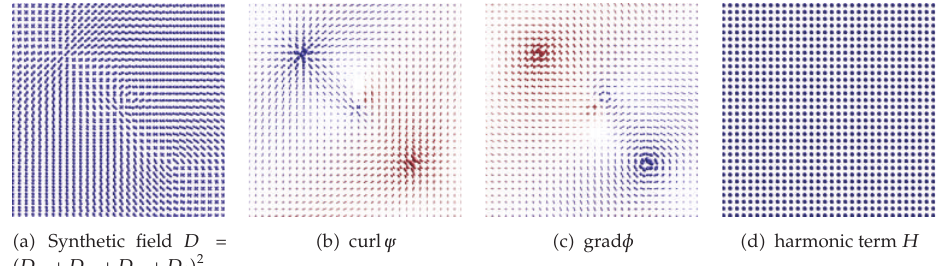
Figure 11: Helmholtz decomposition results for fourth-order synthetic tensor field D (cid:7) curl ψ (cid:8) grad φ (cid:8) H